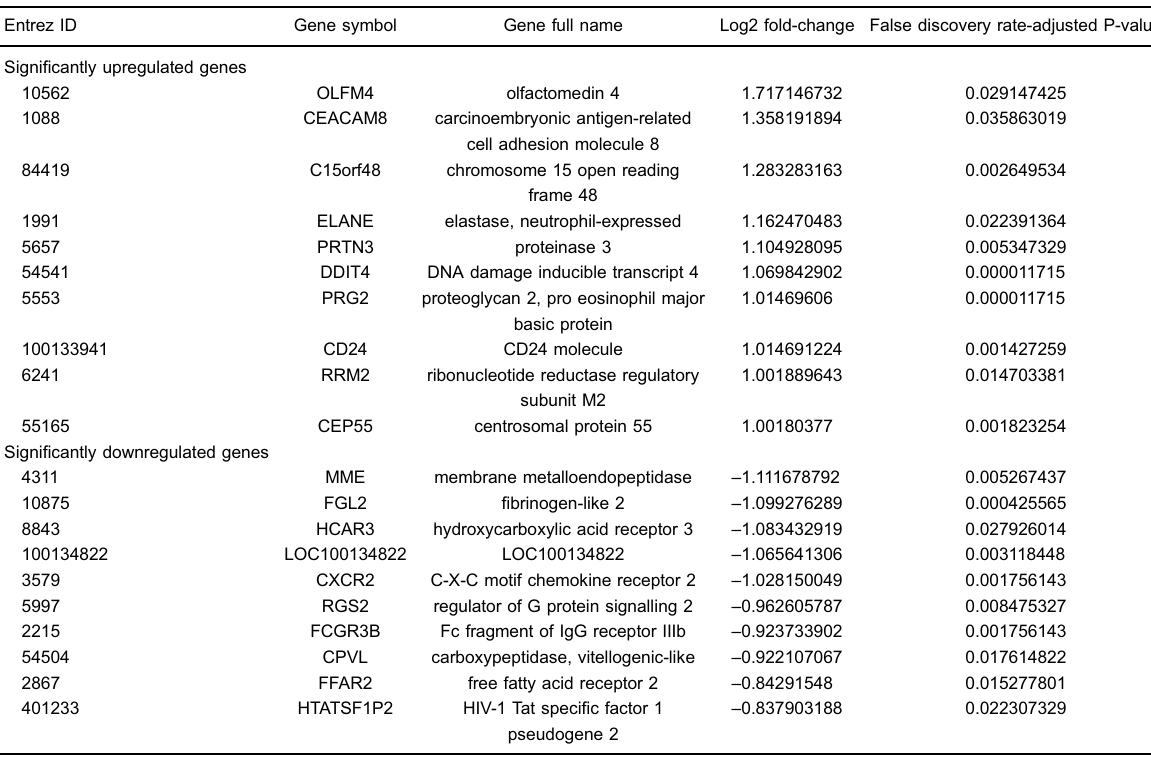
Table 2. The 10 most signi fi cantly upregulated and most signi fi cantly downregulated genes in pediatric septic shock non-survivors. Entrez ID Gene symbol Gene full name Log2 fold-change False discovery rate-adjusted P-value Signi fi cantly upregulated